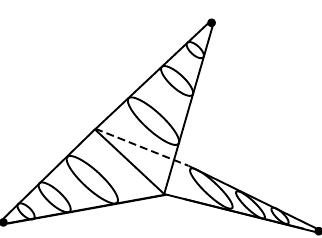
Figure 10. The contribution of the \contact" diagrams to the SYK bilinear three-point function. Even though this diagram is nonplanar, it appears at the same order in 1 =N as the planar diagram, shown previously in (cid:12)gure 2